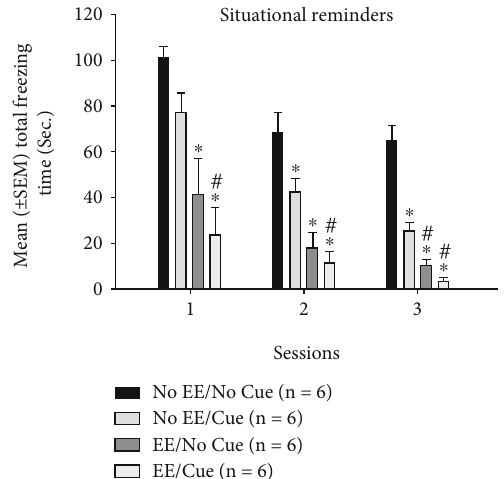
Figure 5: Mean ( ± SEM) freezing time for the situational reminder in sessions 1-3 for the no EE/no cue, no EE/cue, EE/no cue, and EE/ cue groups ( n = 6 , per group). EE: environmental enrichment. ∗ p < 0 : 05 indicates signi fi cant di ff erences compared to the no EE/no cue group; # p < 0 : 05 indicates signi fi cant di ff erences compared to the no EE/cue group.